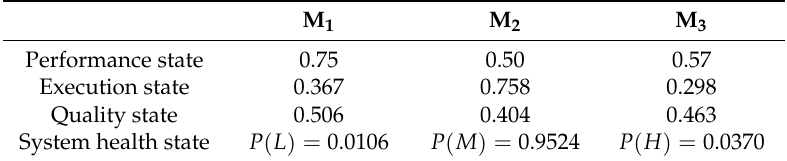
Table 5. Comparison between system health state and different characteristics